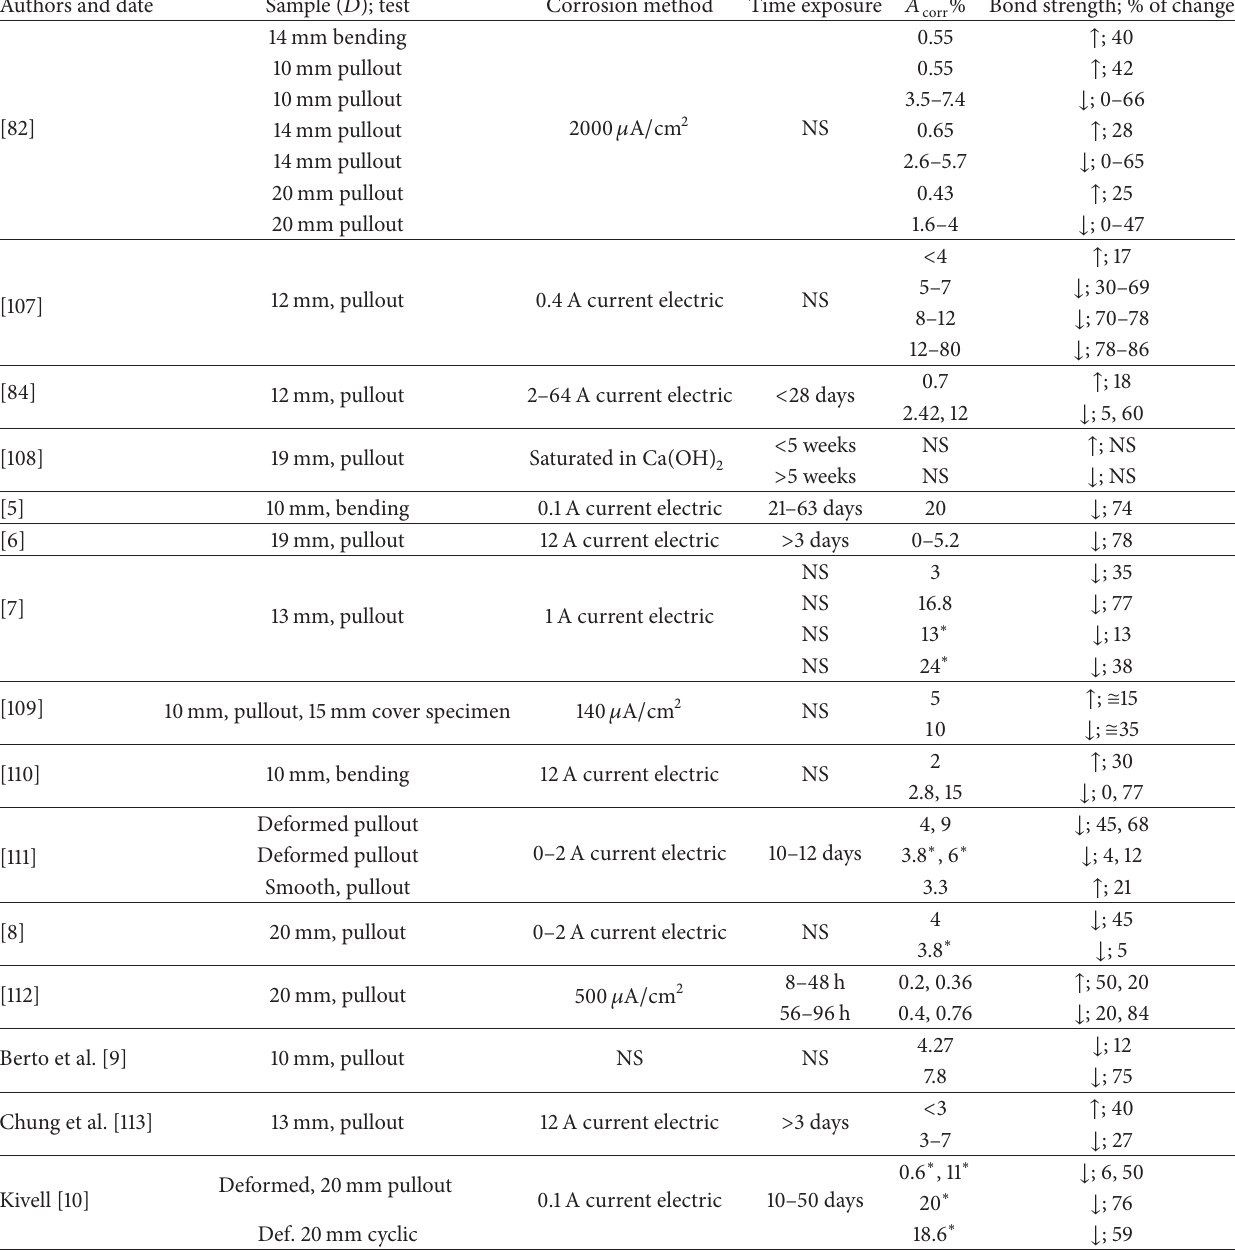
Table 9: Effect of corrosion on bond strength between concrete and steel